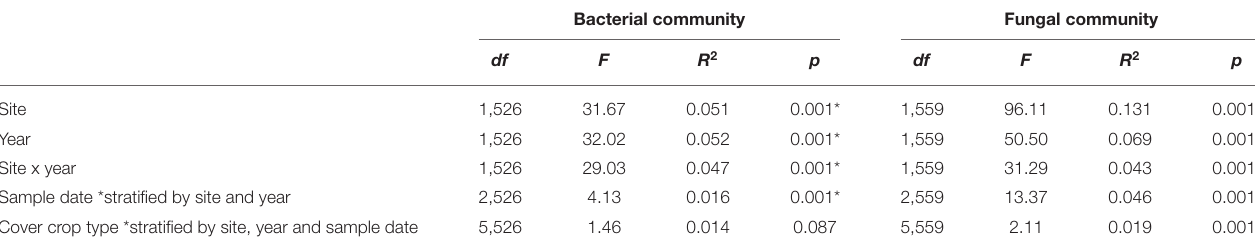
TABLE 1 | PERMANOVA tests were carried out on the entire dataset to evaluate the influences of site, year, cover crop type, cover crop diversity or sample date influenced bacterial and fungal community composition. Bacterial community